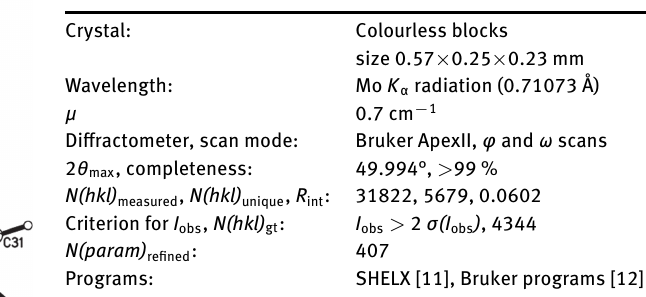
Table 1: Data collection and